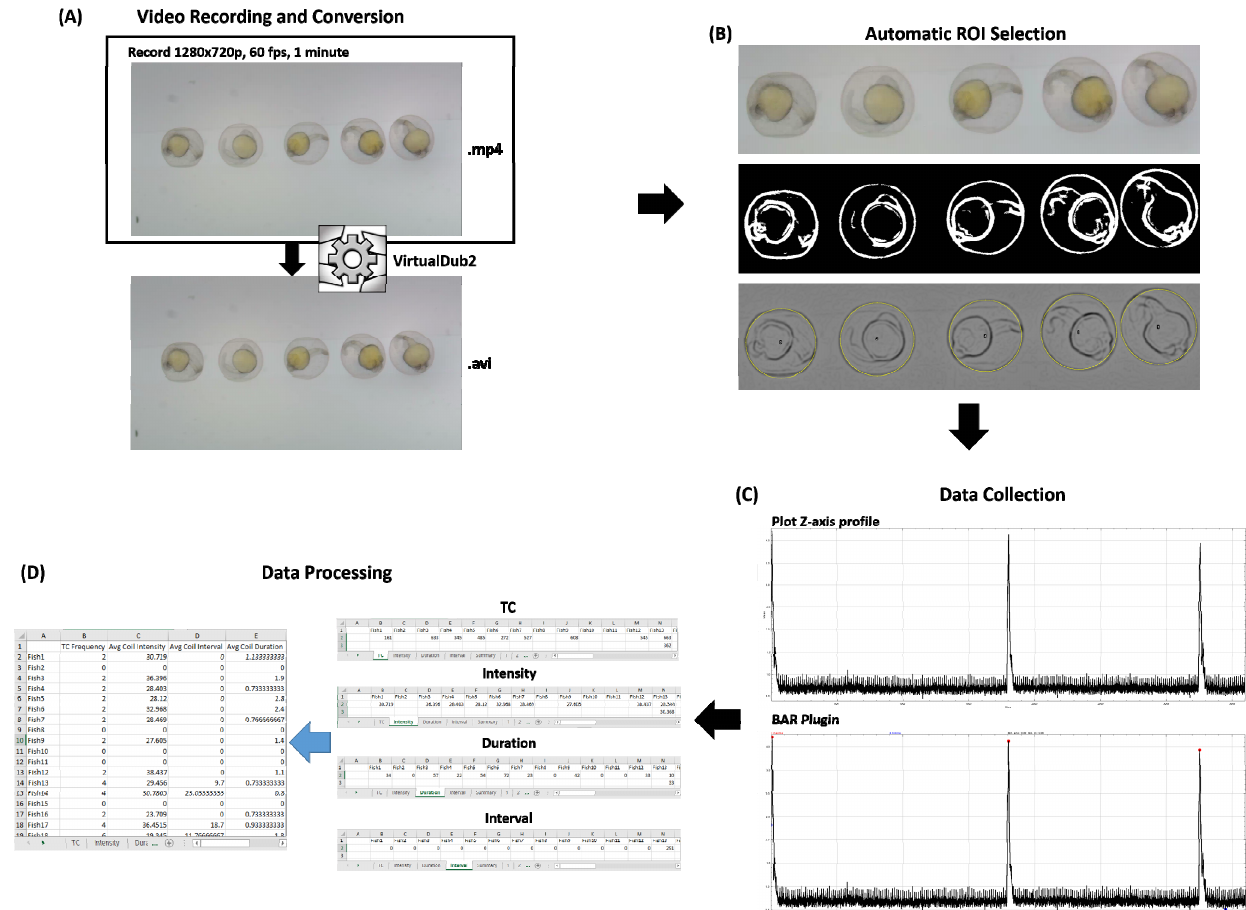
Figure 1. Plotline workflow of TCMacro for zebrafish embryo tail coiling measurement. The process starts with video recording ( A ), automatic ROI Selection ( B ), data collection using Plot Z -axis profile and BAR Plugin ( C ) and the collected data was saved as Excel file (.xlsx) for data processing in excel ( D ).